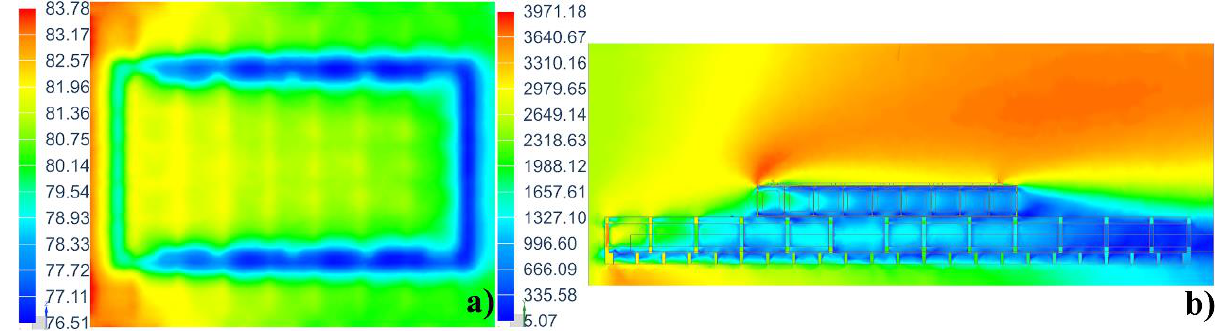
Figure 8. Contour plot of ( a ) temperature field distribution of the mold (unit: °C) and ( b ) velocity field distribution of the air (unit: mm/s).